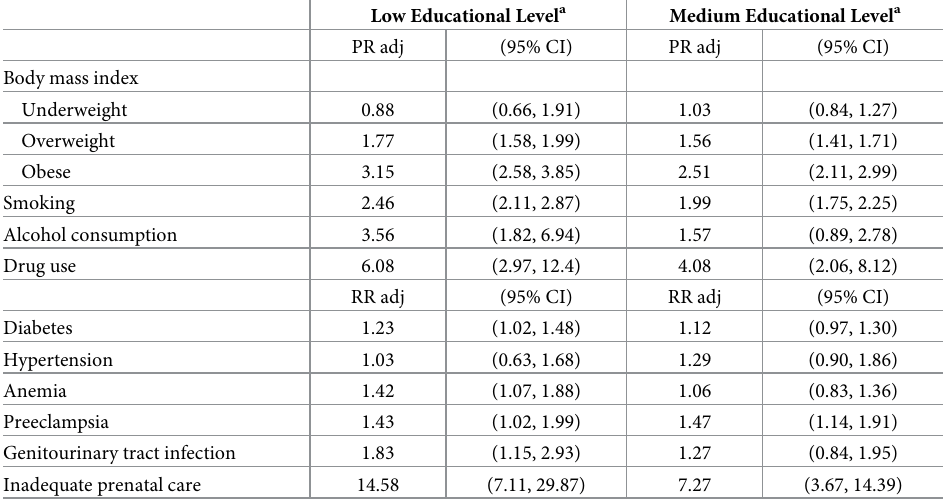
Table 3. Associations between maternal educational level and intermediate variables.